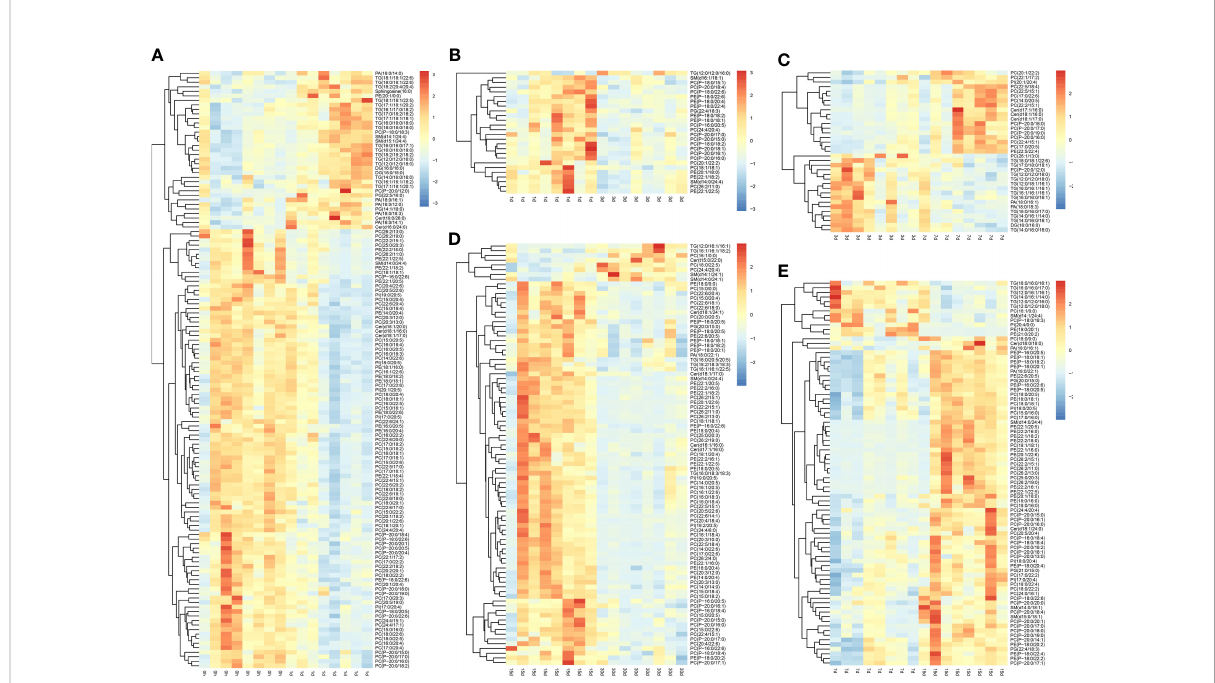
FIGURE 3 Differential lipid metabolites in transplanted pearl oyster P. f. martensii . The relative metabolite level is depicted according to the color scale. Red and blue indicate upregulation and downregulation, respectively. (A) days 0 vs. 1; (B) days 1 vs. 3; (C) days 3 vs. 7; (D) days 7 vs. 15; and (E) days 15 vs.